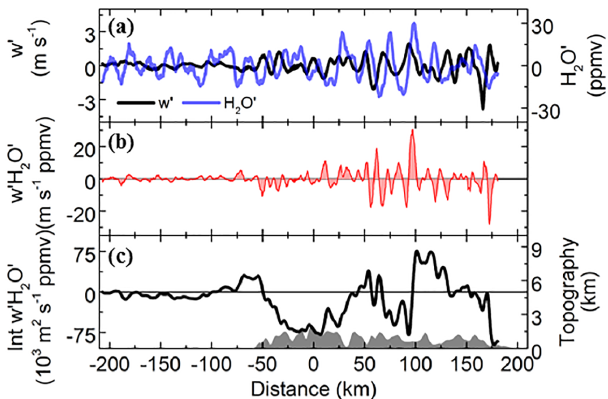
Figure 4. Same flight leg as in Fig. 3. Shown are components of the vertical water vapor flux. The vertical wind perturbation (black) and the water vapor perturbation (blue) in (a) are combined to the local vertical water vapor flux w (cid:48) H 2 O (cid:48) (b) . The bottom panel (c) shows the integrated vertical water vapor flux R w (cid:48) H 2 O (cid:48) d x and the topography.